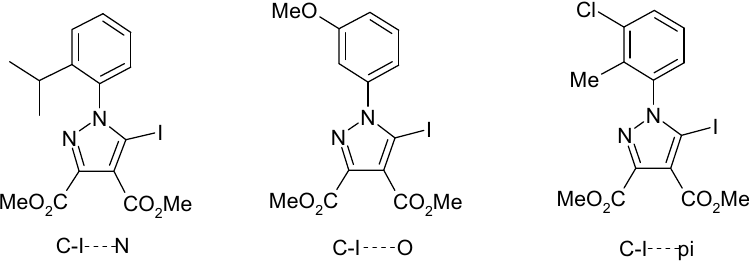
Figure 2. Previously investigated structures and types of halogen interactions observed.